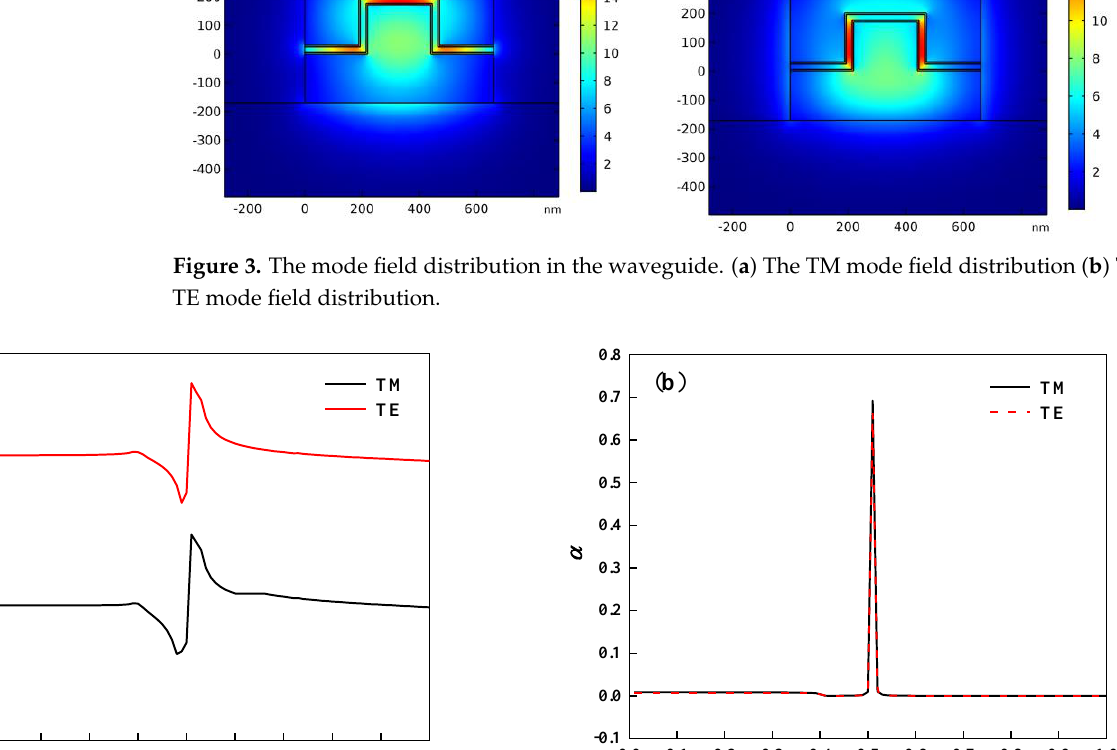
Figure 4. The real and imaginary parts of the effective refractive index changes in transverse magnetic (TM) and transverse electric (TE) modes at different graphene chemical potentials. ( a ) The effective refractive index real part. ( b ) The imaginary part of effective refractive index.